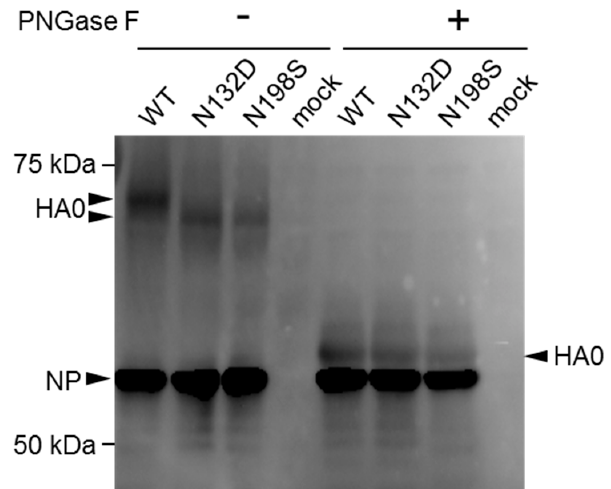
Figure 4. Deglycosylation of HA caused by mutation. MDCK cells were infected with viruses bearing a wild-type or mutant HA (N132D or N198S) and incubated at 37 °C for 12 h. Proteins were extracted from infected or mock-infected cells and treated with or without PNGase F. The samples were run on an 8% sodium dodecyl sulphate (SDS)-polyacrylamide gel and transferred to a polyvinylidene fluoride (PVDF) membrane for Western blotting analysis using anti-H9N2 virus mouse polyclonal antibody as the primary antibody. HA0 and NP are indicated by arrowheads.